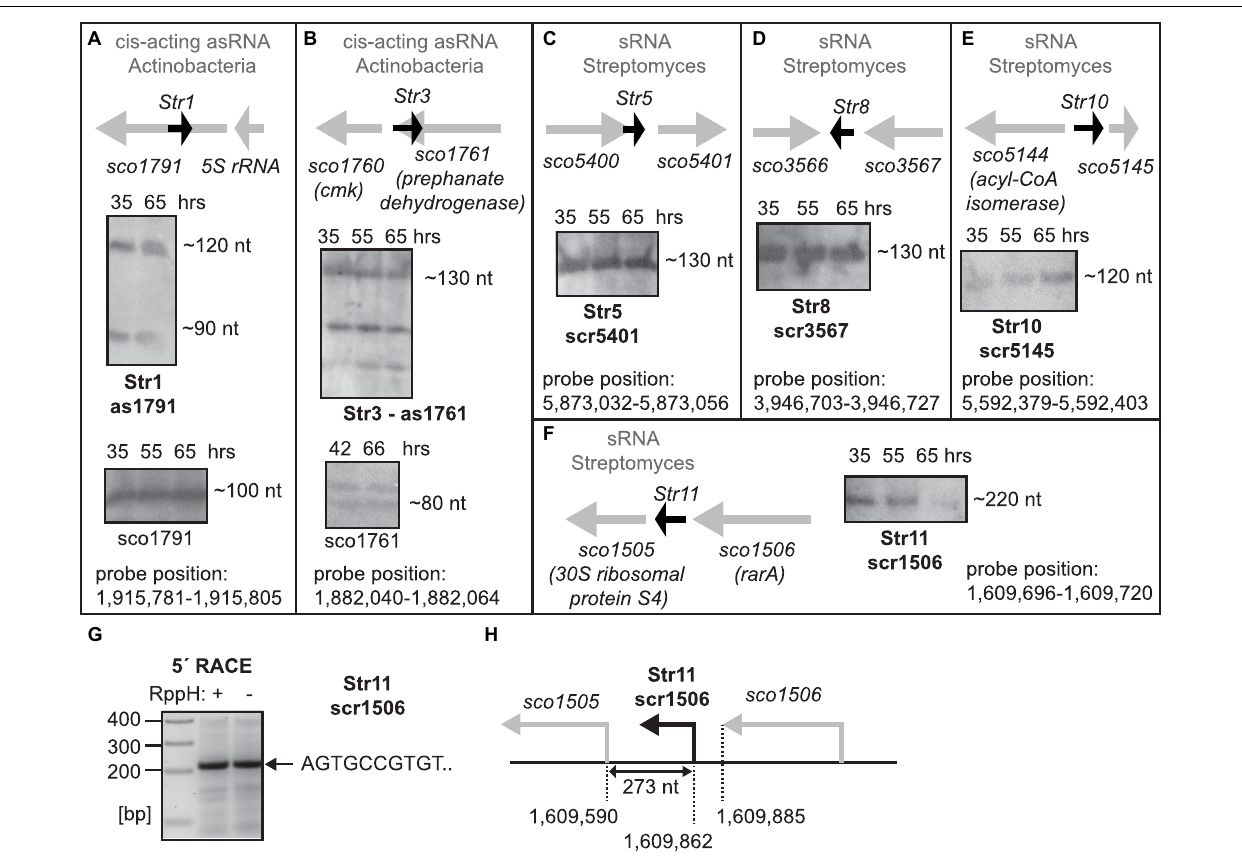
and Str3 sRNAs suggests that these sRNAs might be cis -acting respective regulated